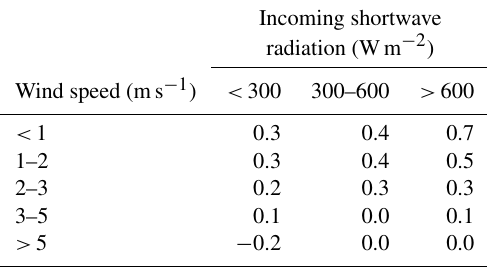
Table 3. The average hourly temperature difference ( ◦ C) between Veriteq loggers and the WRS temperature sensor at different wind speeds and incoming shortwave radiation